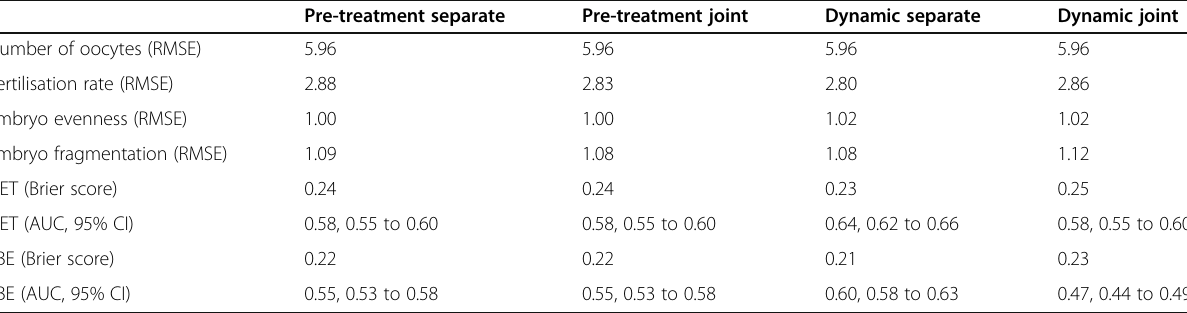
Table 3 Performance metrics for the four sequential prediction models Pre-treatment separate Pre-treatment joint Dynamic separate Dynamic